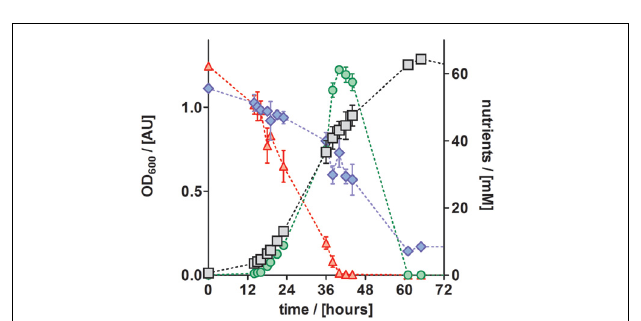
FIGURE 6 | Growth curve and nutrient analyses of anaerobically grown P. denitrificans Pd1222 on the improved medium, supplemented with trace element solution TE-3-Zn (Table 2). Growth was followed by OD 600 measurements (gray squares). Consumption of acetate (blue diamonds) and nitrate (red up triangles), as well as production and consumption of nitrite (green circles) were quantified. All data represent triplicates; error bars indicate standard deviation and may be smaller than the